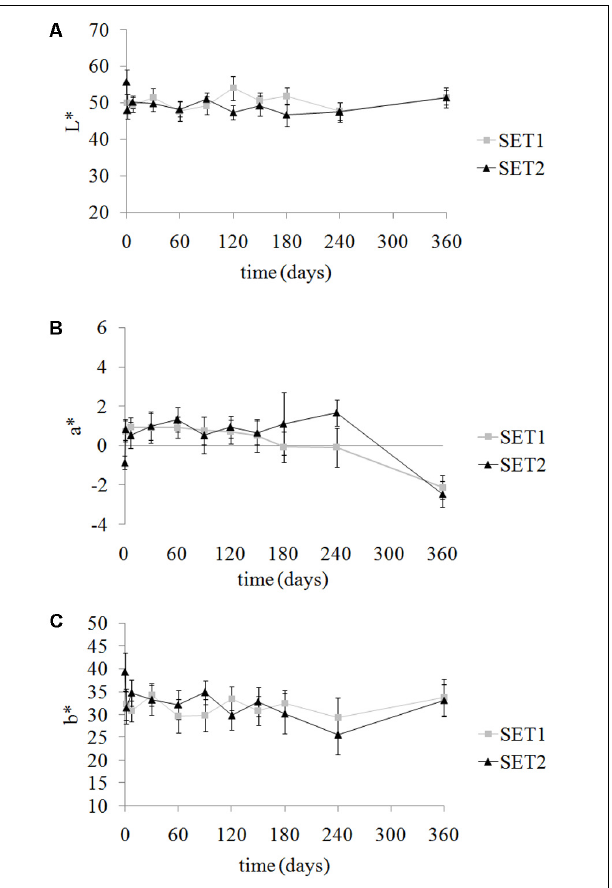
FIGURE 2 | Instrumental firmness of bio-preserved (SET1, gray bars) and control (SET2, black bars) Bella di Cerignola Spanish-style olives packaged in PTE bags (olive/brine ratio, 8/1). Means and standard deviations were obtained from measurements made on three different olives analyzed from duplicate packages per each experiment ( n = 12).